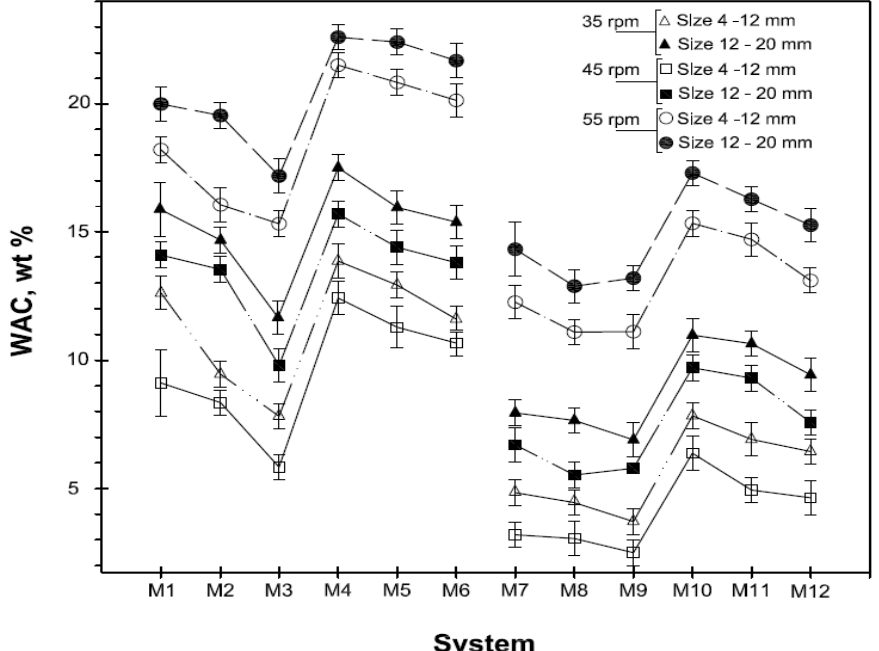
Figure 7. Water absorption capacity of the artificial aggregates after 56 days curing.